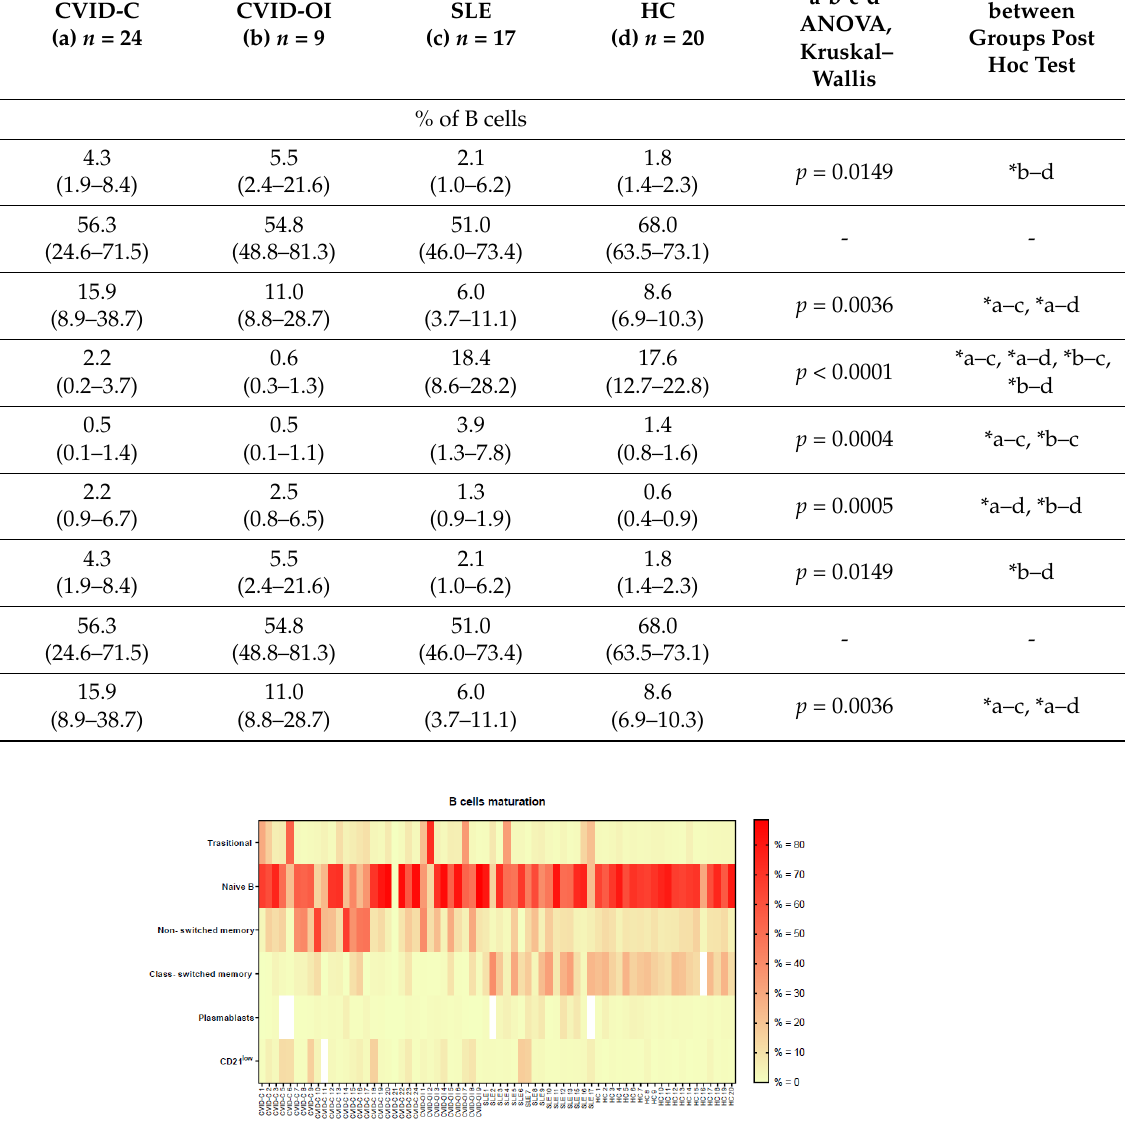
Figure 4. The proportions of B lymphocyte maturation for each patient with CVID with complicated phenotype (CVID-C) group, CVID phenotype limited to only infections (CVID-OI group), patients with SLE, and healthy controls (HCs). Data expressed as a median percentage (%).